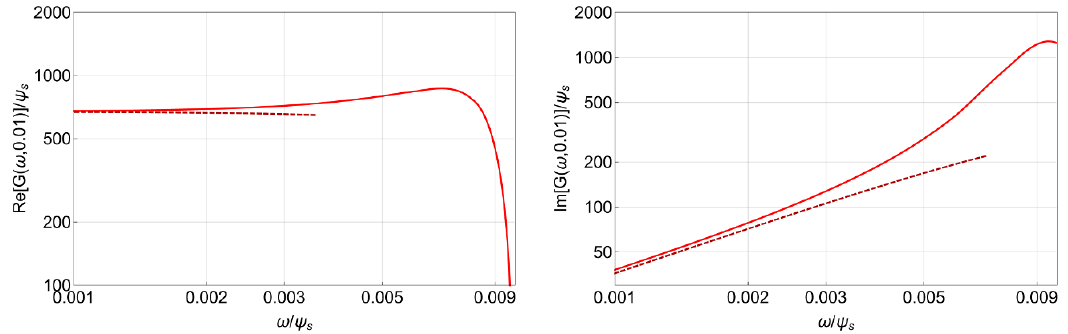
Figure 4 . We compare the analytic (dashed) and the numerical (solid) result for the two point function G ( !; 0 : 01) for real frequencies.